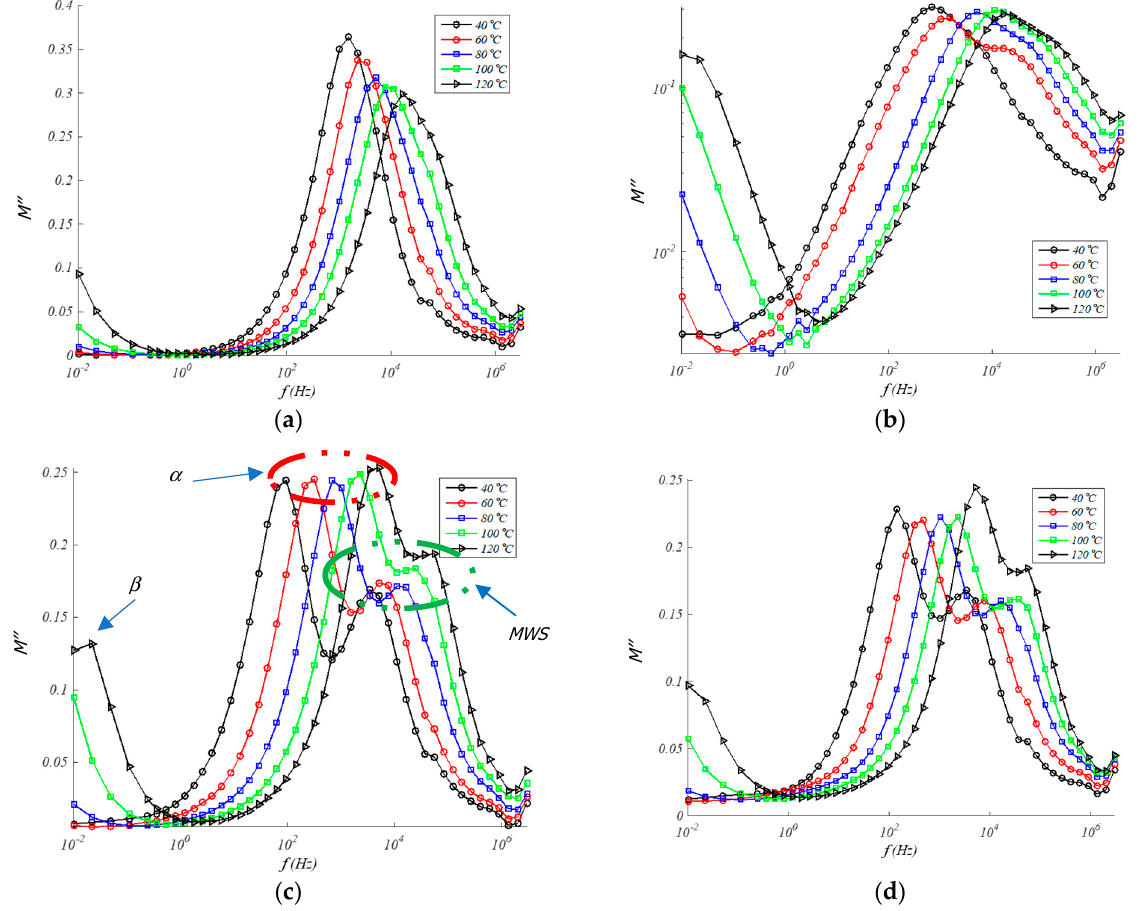
Figure 8. Imaginary modulus in EPDM composites for: ( a ) 0% GTR or neat EPDM; ( b ) EPDM + 5% GTR; ( c ) EPDM + 10% GTR; ( d ) EPDM + 20% GTR.